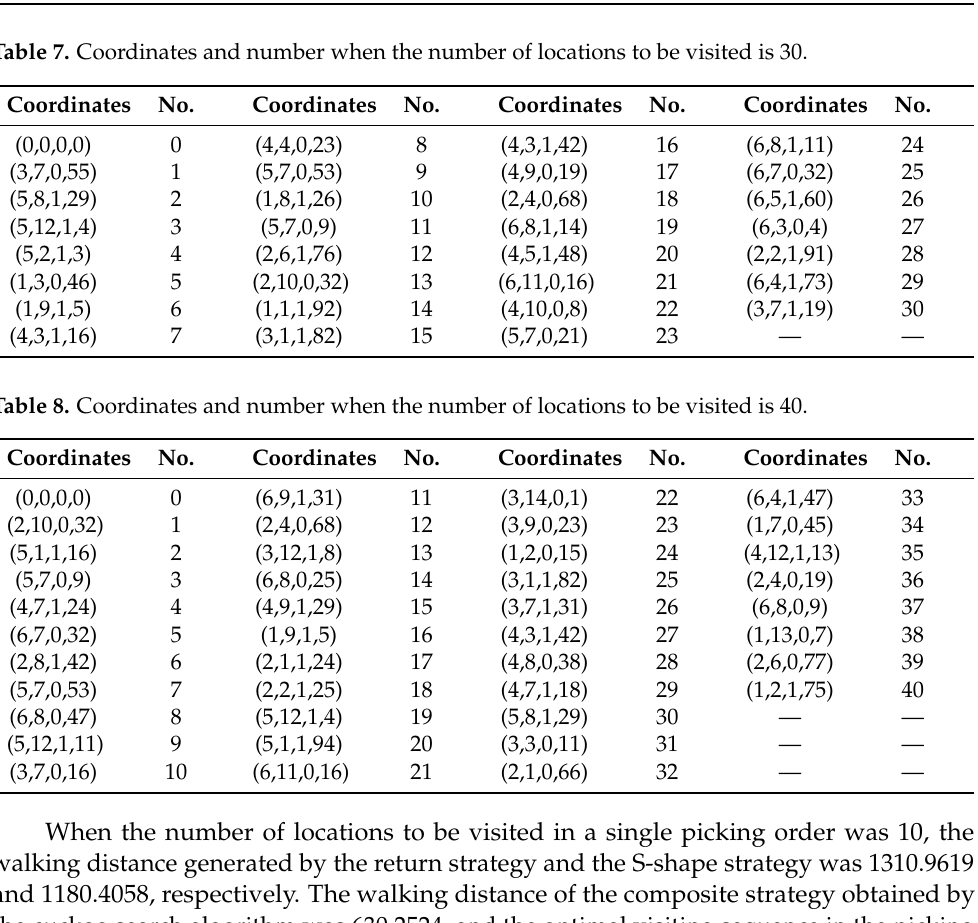
Table 7. Coordinates and number when the number of locations to be visited is 30. Coordinates